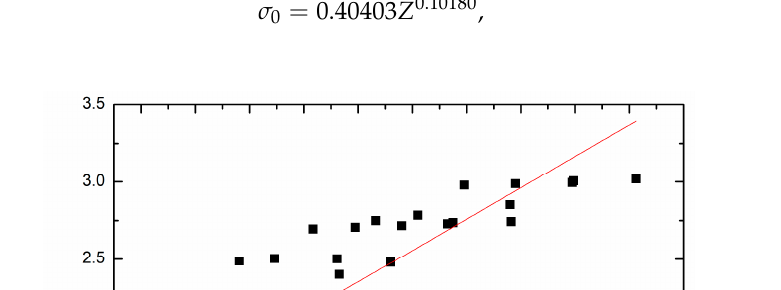
Figure 11. The relationship between ln σ 0 and ln Z .